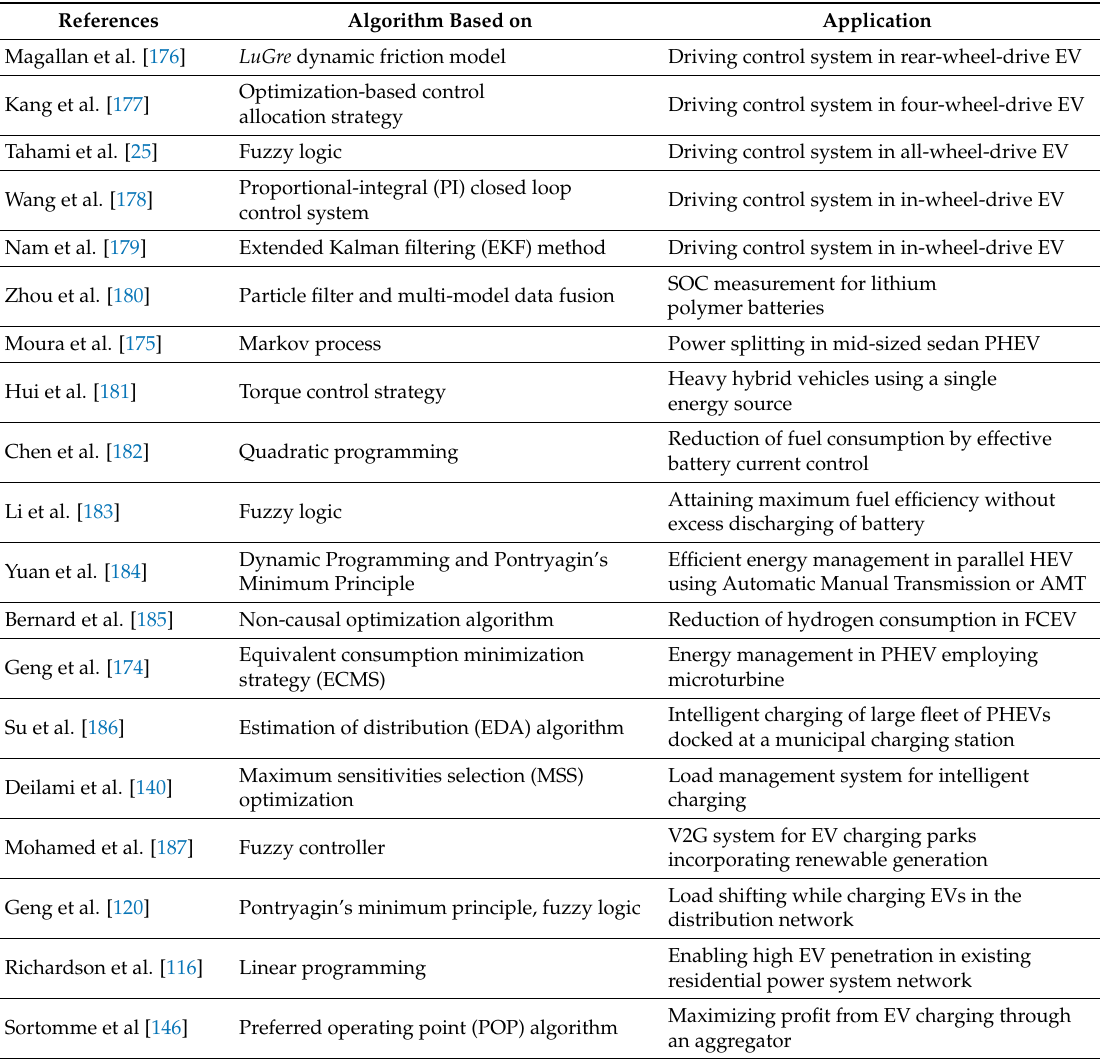
Table 31. Summary of the control algorithms